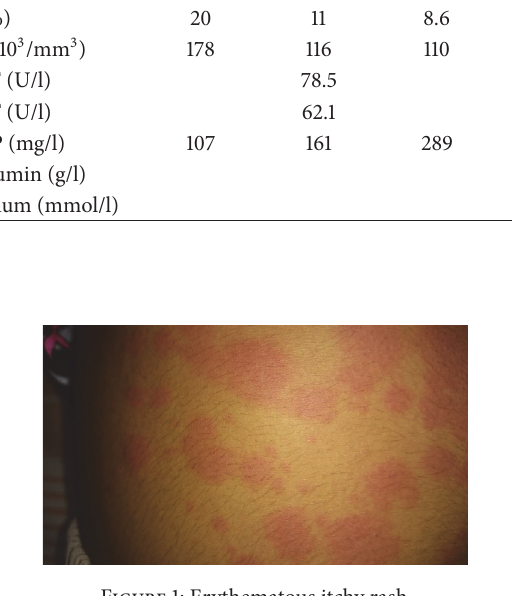
Figure 1: Erythematous itchy